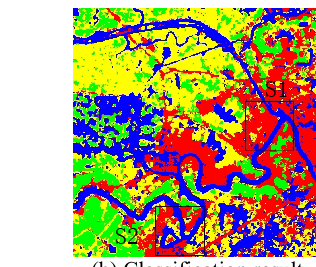
Table 1. Comparison of five sub-pixel mapping